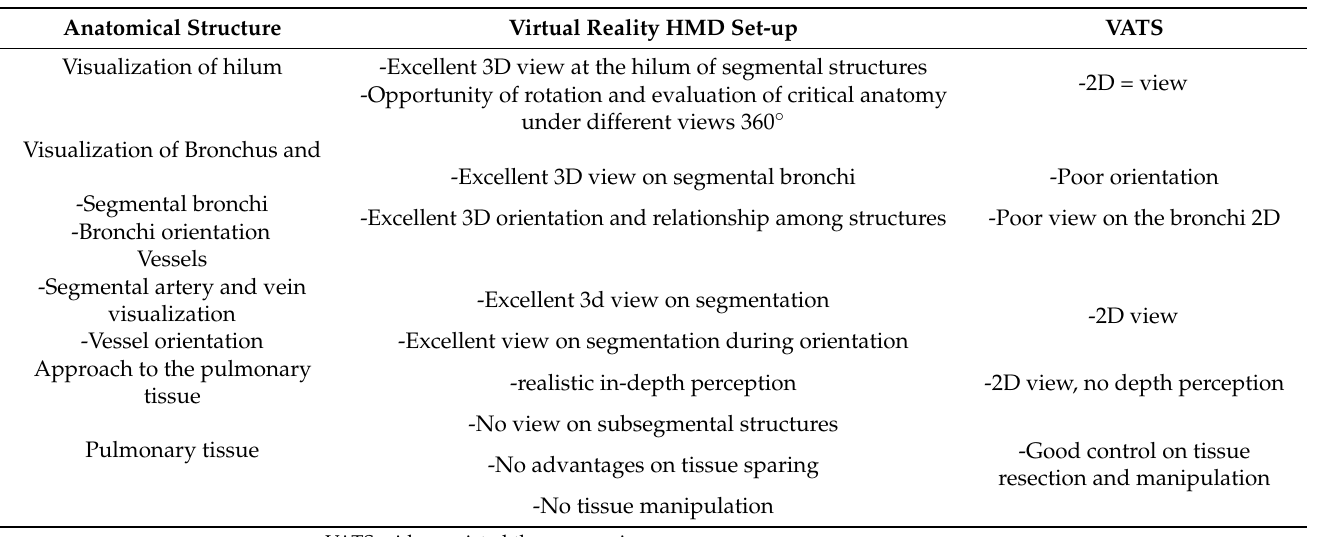
Table 2. Video-assisted thoracoscopic surgery (VATS) and Virtual Reality HMD set-up. Visualization of the anatomical structures.